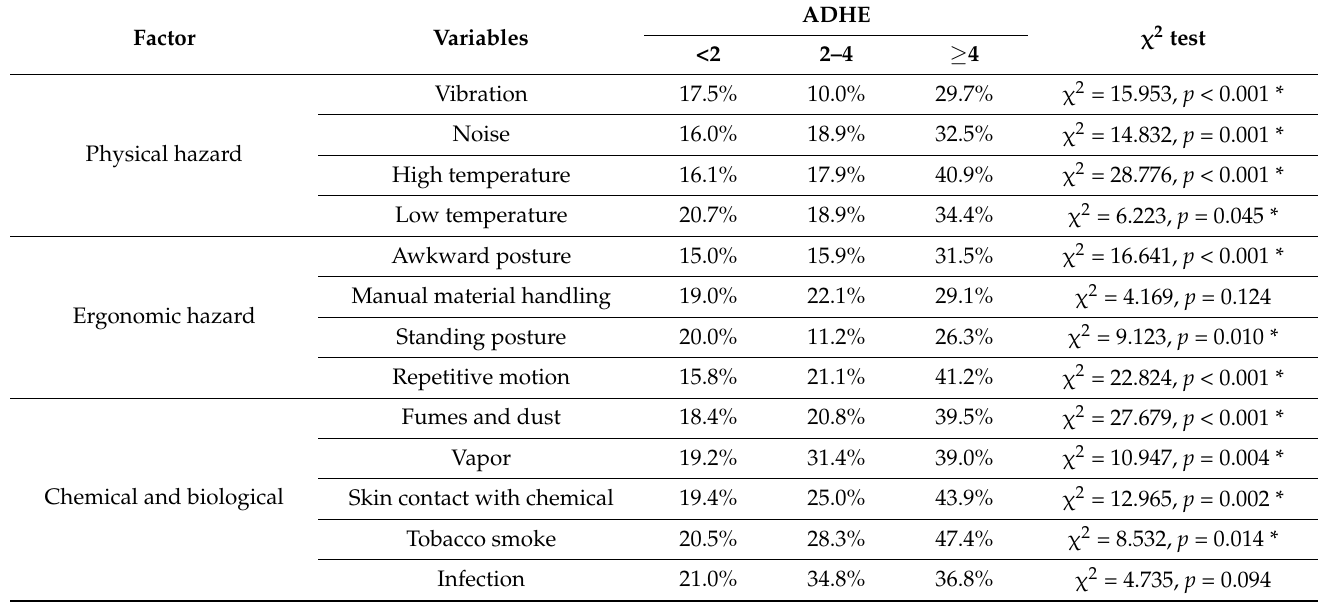
Table 8. Distribution of subjective upper limb pain by the degree of hazard